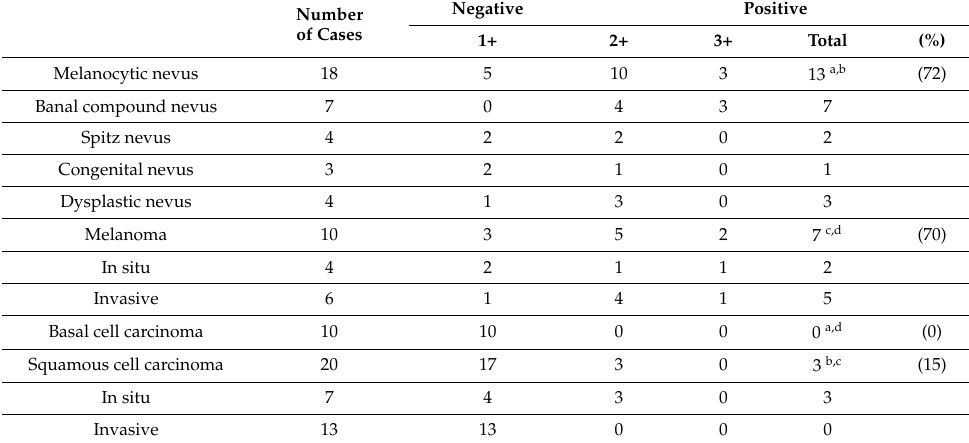
Figure 2. Expression of gankyrin in a positive squamous cell carcinoma in situ ( a ) compared to normal epidermis ( b ). The gankyrin expression in the carcinoma is predominantly nuclear. The normal epidermis demonstrates weak background reactivity for gankyrin. Some of the inflammatory cells in the dermis stain with moderate intensity ( a ). Original magnifications 200×. Table 1. Gankyrin immunoreactivity in cutaneous neoplasms.